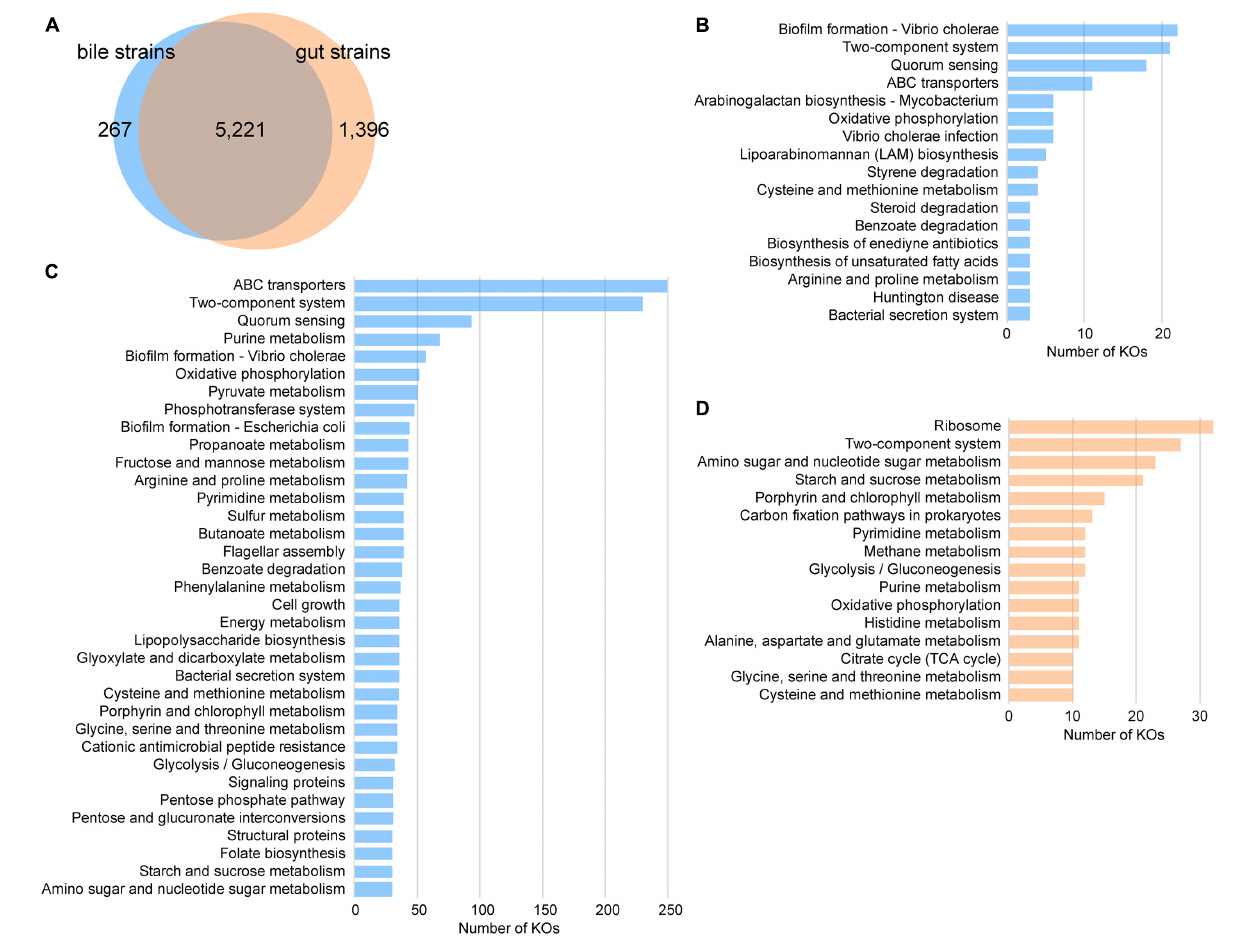
7 α / β -dehydroxylation) ( Supplementary Table 5 ). These genes spanned all 35 genome-sequenced strains, suggesting that the bile bacteria have widely participated in bile acid